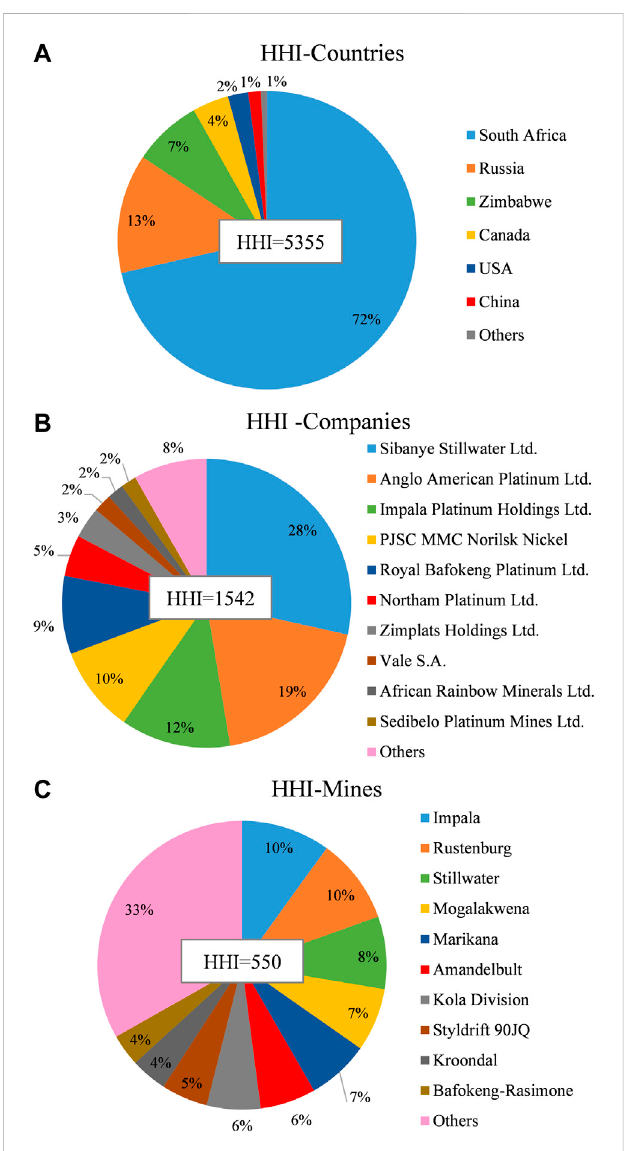
FIGURE 6 platinum companies, (C) HHI index of the countries of shareholders of platinum